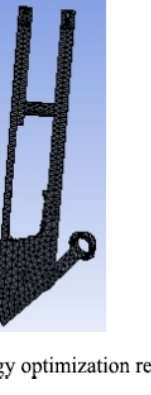
Figure 13. The clamping arm optimization results.